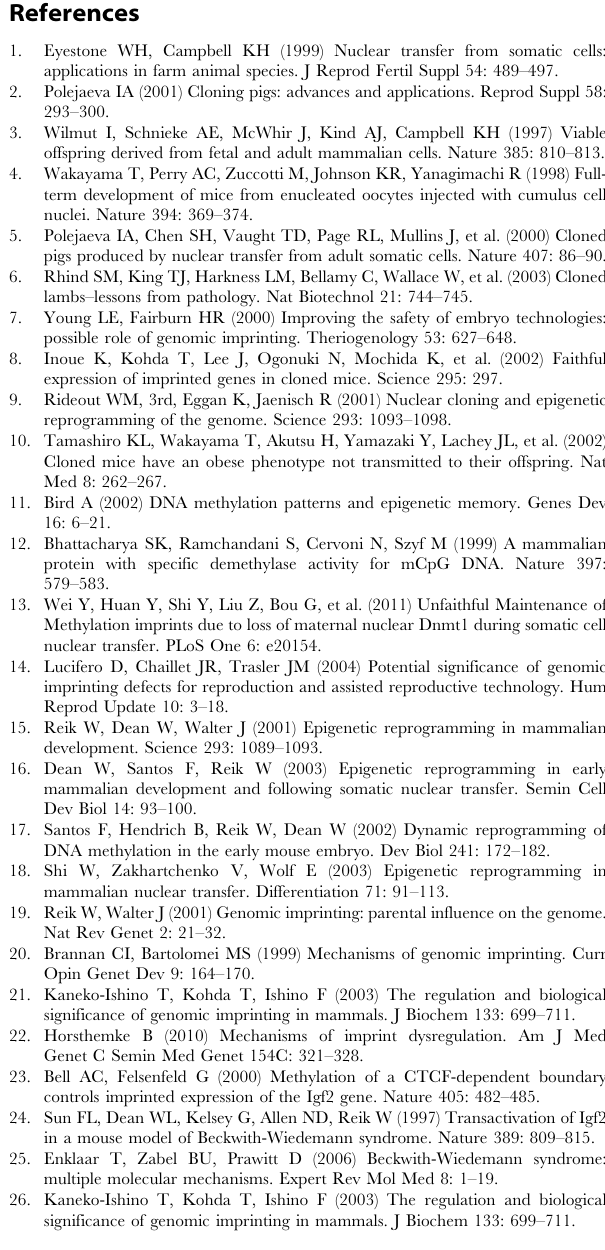
Table S4 Raw data of IGF2R putative DMR methylation percentages in different tissues of four cloned pigs and three wild-type pigs. Table S5 The methylation statuses of each imprinted gene in the analyzed cloned pig samples. Table S6 The methylation statuses of each imprinted gene in all analyzed tissues of the four cloned pigs. Table S7 The overall methylation patterns of each imprinted gene in all samples of cloned pigs.